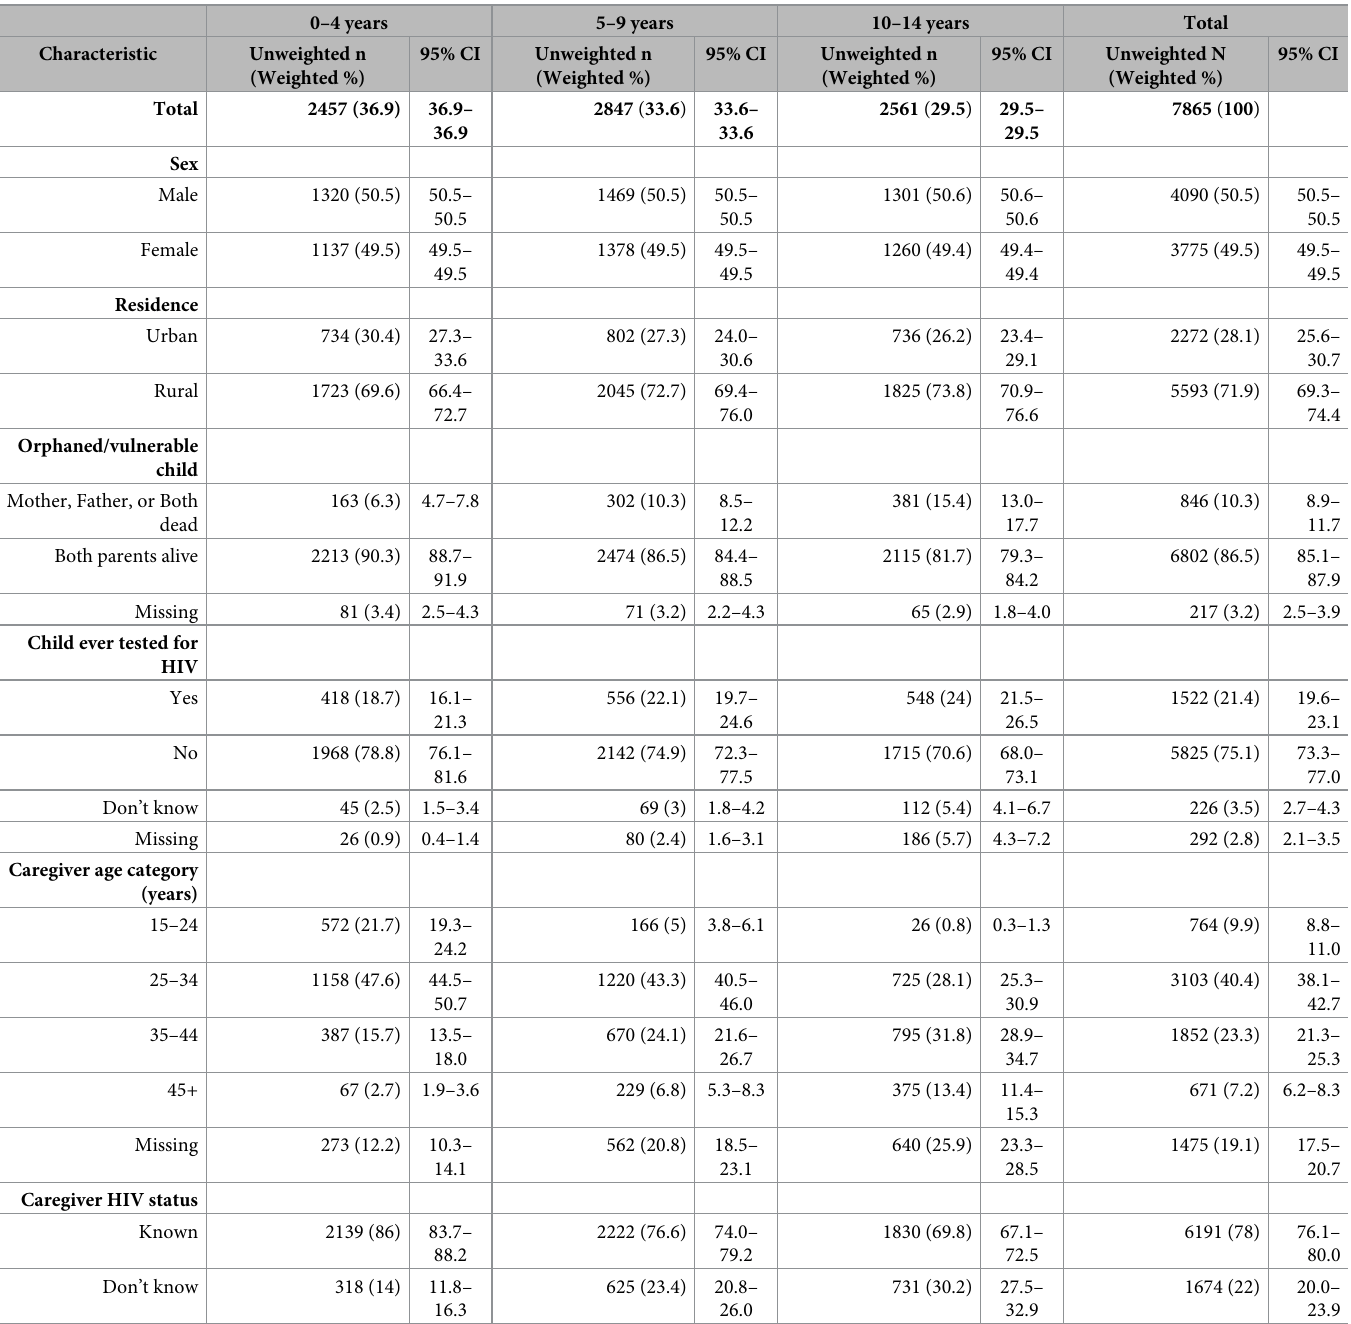
Table 1. Characteristics of children aged 0–14 years by age group-KENPHIA,